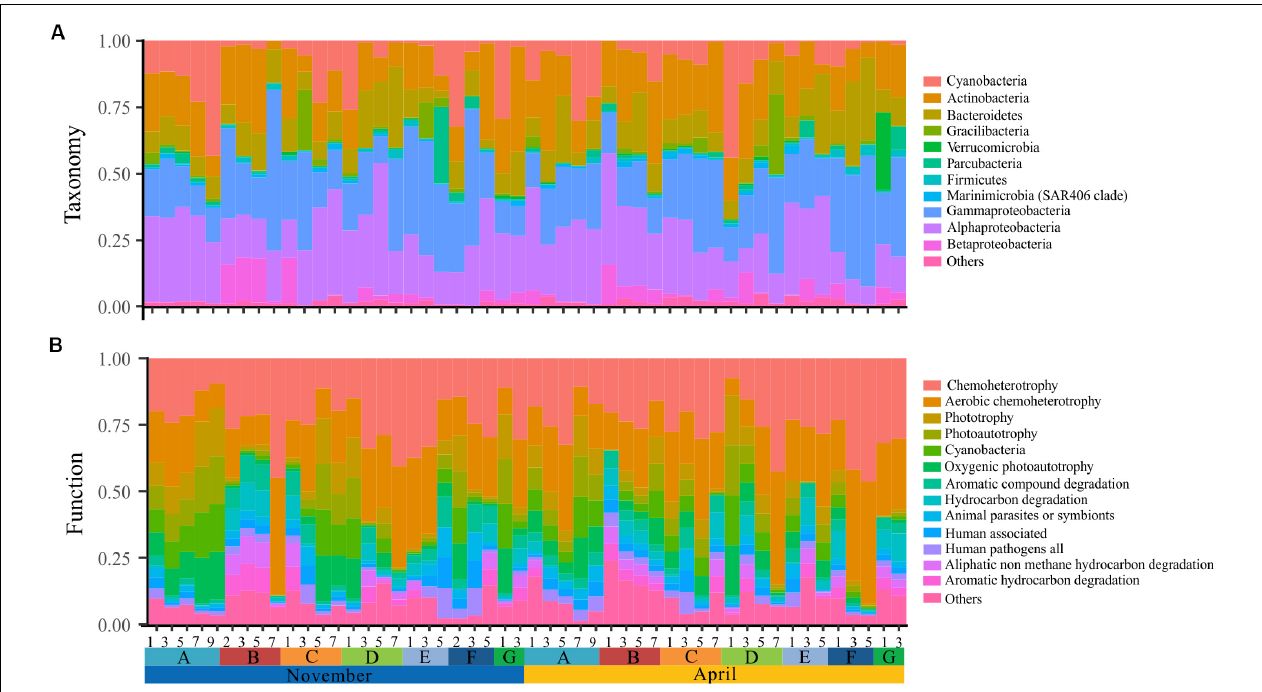
FIGURE 2 | Spatial and temporal variation of taxonomy and function of surface bacterioplankton communities in the overwintering ground. (A) Phylum-level (phylum Proteobacteria is grouped into the class level) taxonomic compositions of all samples. (B) Functional characterization of all samples.